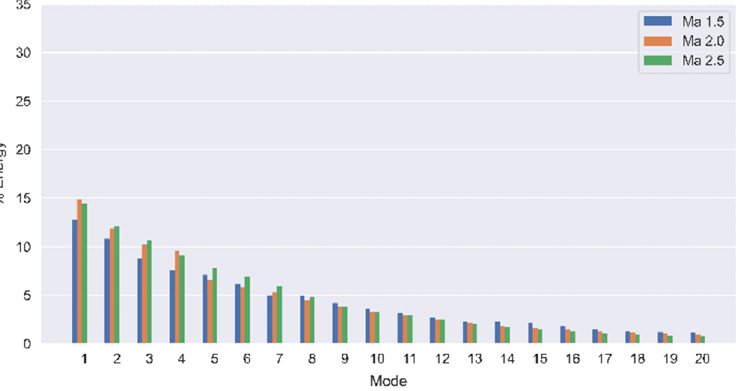
Figure 8. The energy percentage of the first 20 modes behind the MVG in three different Mach num- bers.